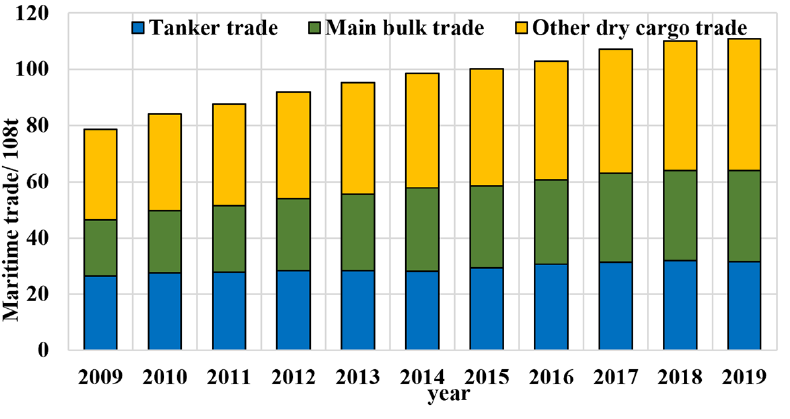
Figure 1. Global shipping trade from 2009 to 2019.